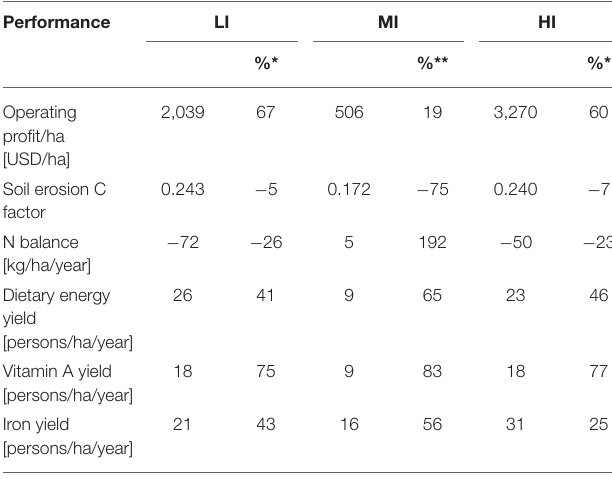
TABLE 2 | Performance of the farm types and the contribution of banana to the performance parameters (%), as calculated by the FarmDESIGN model.